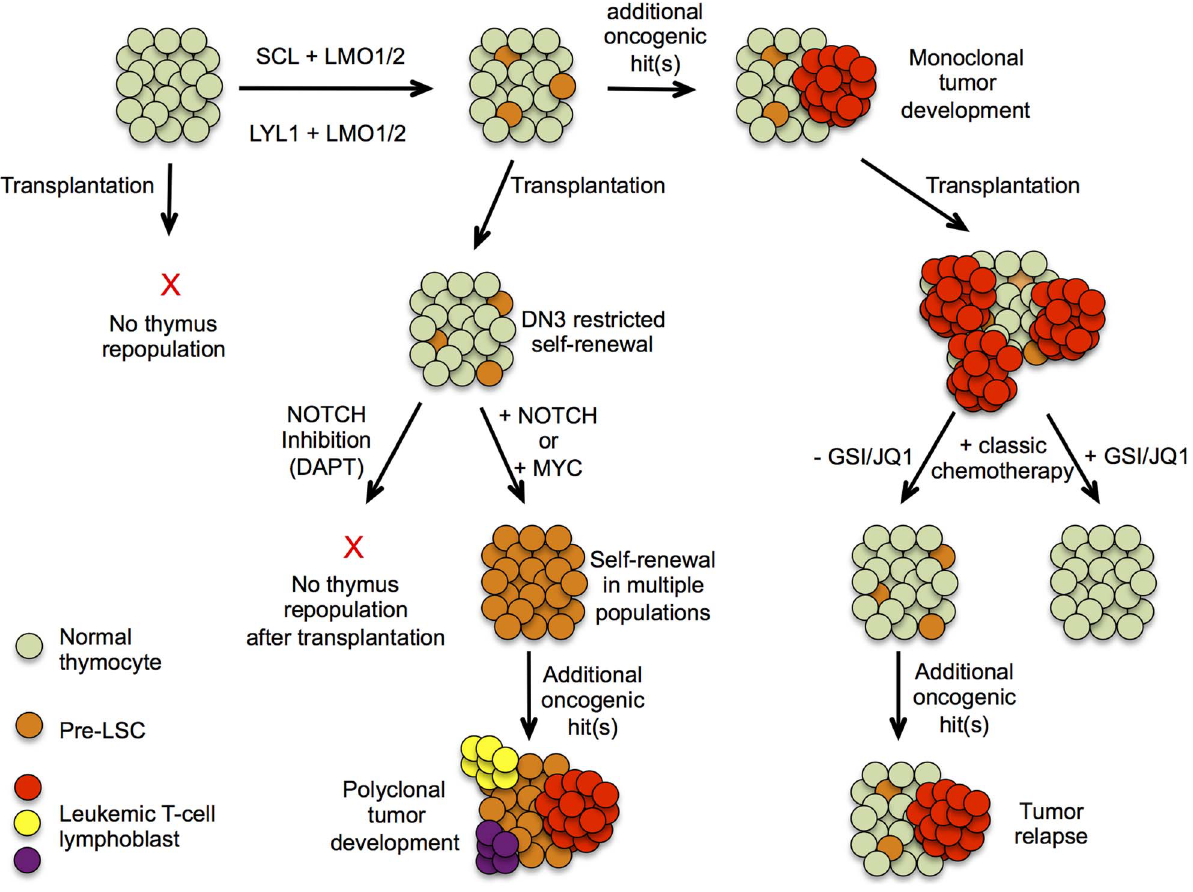
Fig. 1. Hypothetical model describing pre-leukemic stem cells formation and T-ALL development in SCL tg LMO1 tg mice. Schematic presentation of T-ALL progression based on experimental evidence presented by Gerby et al. Upper part represents the progression of T-ALL development in a thymus initiated by the formation of a pre-leukemic stem cell population, allowing clonal expansion and subsequent acquisition of oncogenic mutations, eventually leading to a mono/oligoclonal tumor. The lower part depicts results obtained after transplantation of thymocytes at different stages of tumor development and the effects of altering NOTCH1 signaling or its downstream component MYC on their repopulating